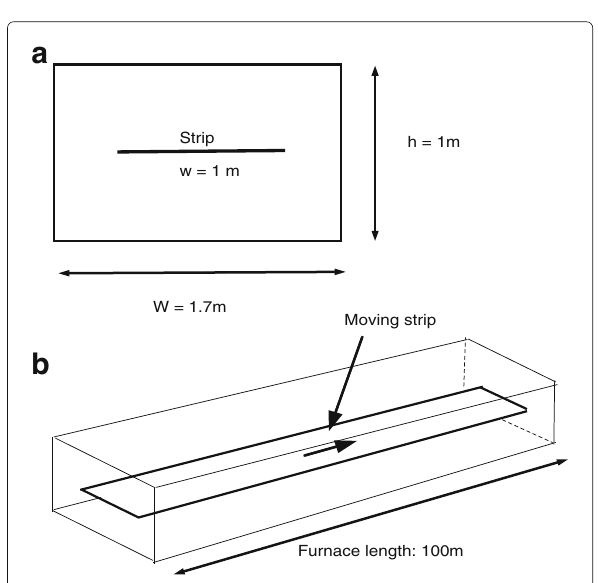
Fig. 4 Sketch of the furnace; a cross-section, b side